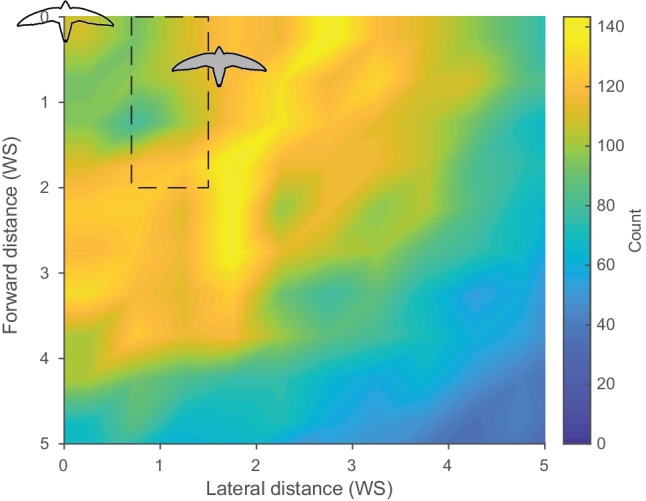
Distribution of nearest neighbors in the horizontal slice (±1 wingspan elevation) from a chimney swift roosting flock (Evangelista et al., 2017).The silhouettes show the position of the focal bird at the origin and the lateral and horizontal position modes. The dashed line box shows the ‘aerodynamic neighbor’ region for comparison with shorebird flocks Figure 3—figure supplement 2. Note that the lateral and horizontal modal positions are calculated separately, and the result is not necessarily congruent with the most populated 2D grid cell. Data used for generating this figure are available in Figure 3—source data 1.